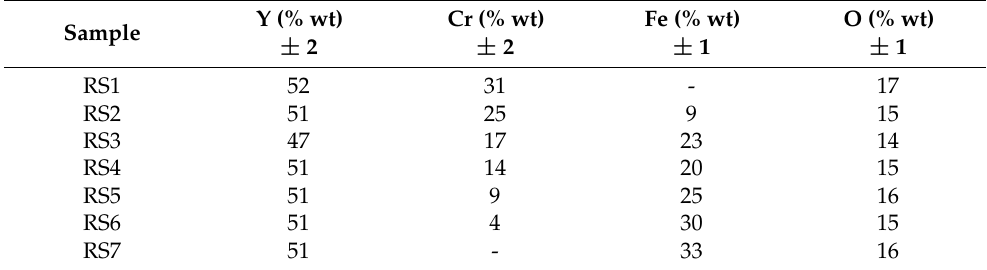
Figure 2. ( a – c ) SEM images for the RS1, RS3, and RS7 samples (bar length = 1 µm). The magnified area was performed in high resolution mode, and the elemental mapping area for each sample is given in ( d – m ) images. SEM images for the RS2, RS4, RS5, and RS6 samples ( n – q ) (bar length =10 µm). ( r ) The EDS for the RS1–RS7 samples. Table 1. Weight percentage composition of the elements found in all samples.